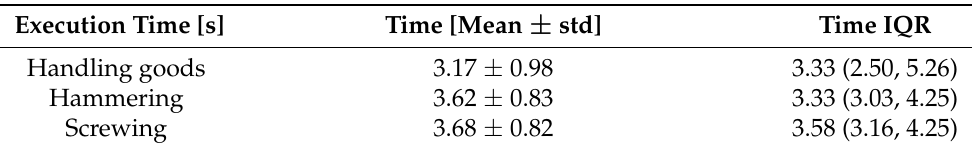
Table 3. Mean time, standard deviation and interquartile range of the execution time spent perform- ing the working activities computed for the eight enrolled